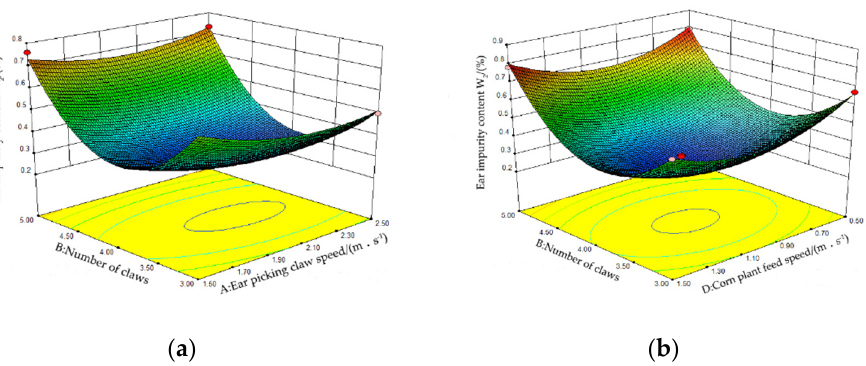
Figure 10. Effect of the interaction of factors on the impurity content of the ears. ( a ) Interaction between the speed and number of picking claws; ( b ) interaction between the straw feeding speed and number of picking claws.